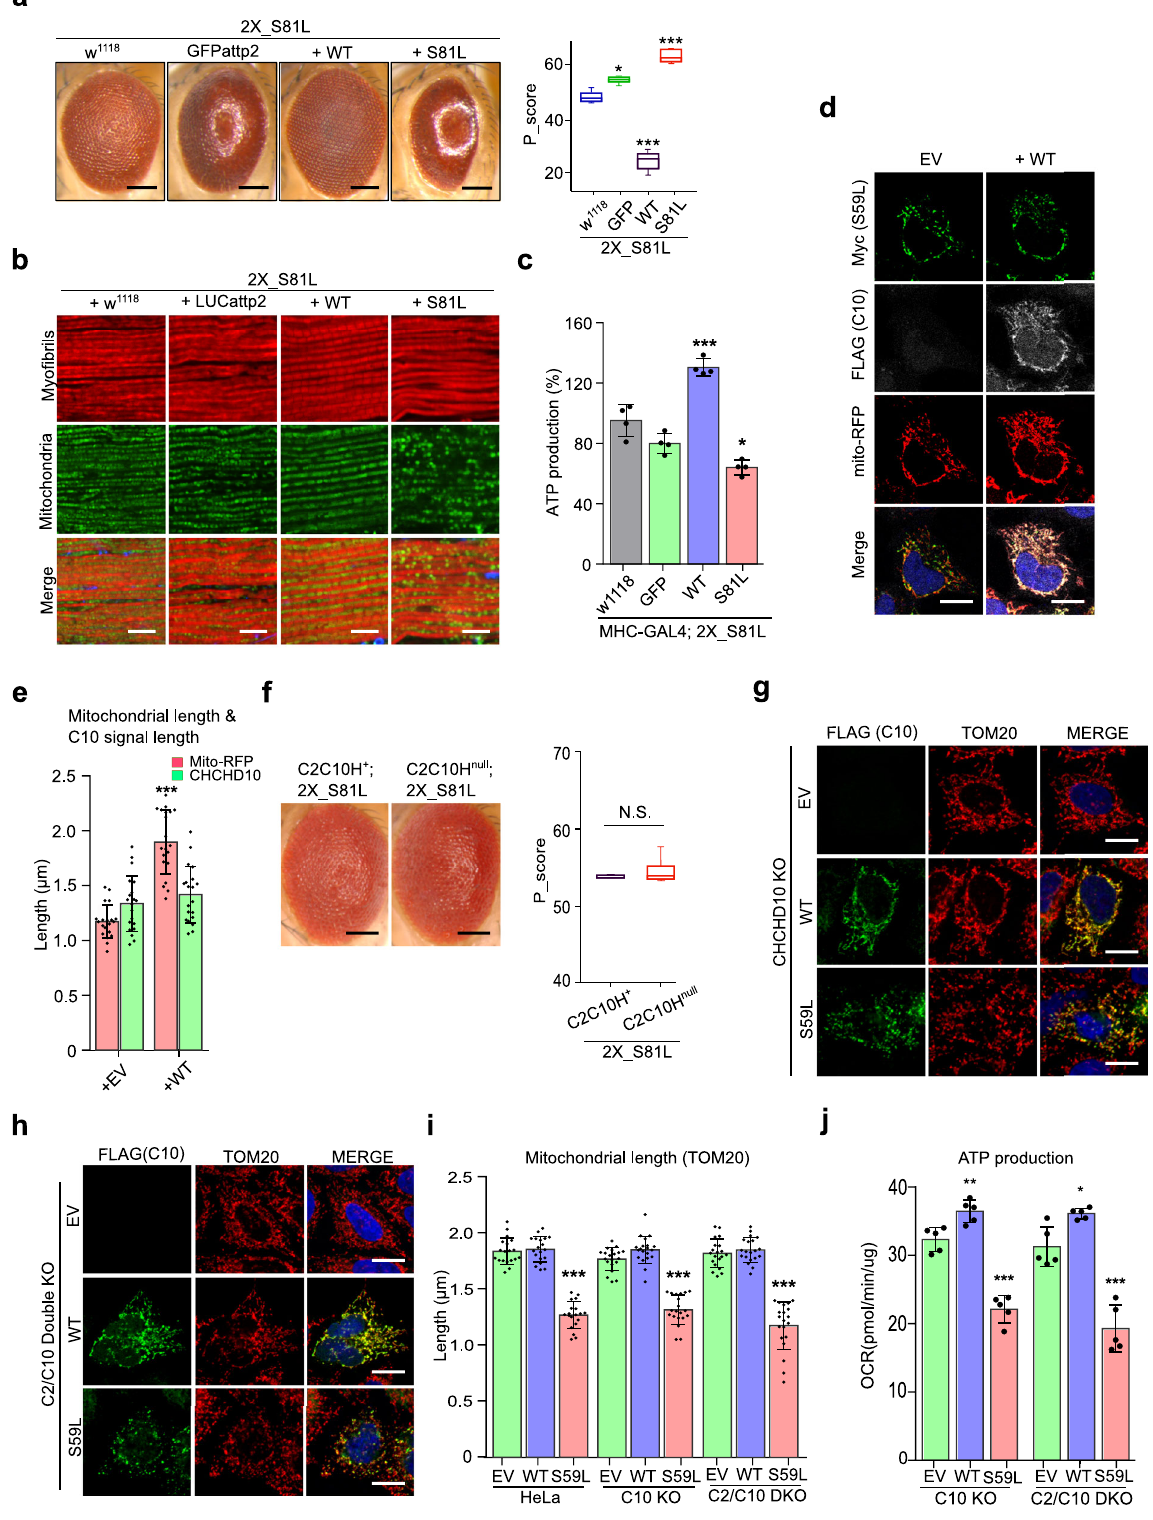
induced rough eye phenotype would not be present in the C2C10H null background if it is a dominant-negative